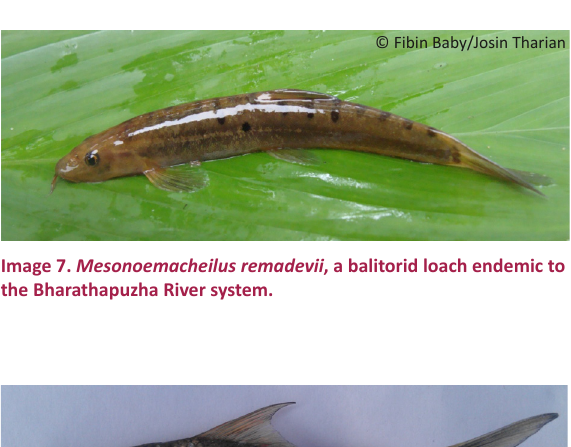
Table 2. Morphometric characteristics of Osteochilichthys longidorsalis collected from Bharathapuzha River